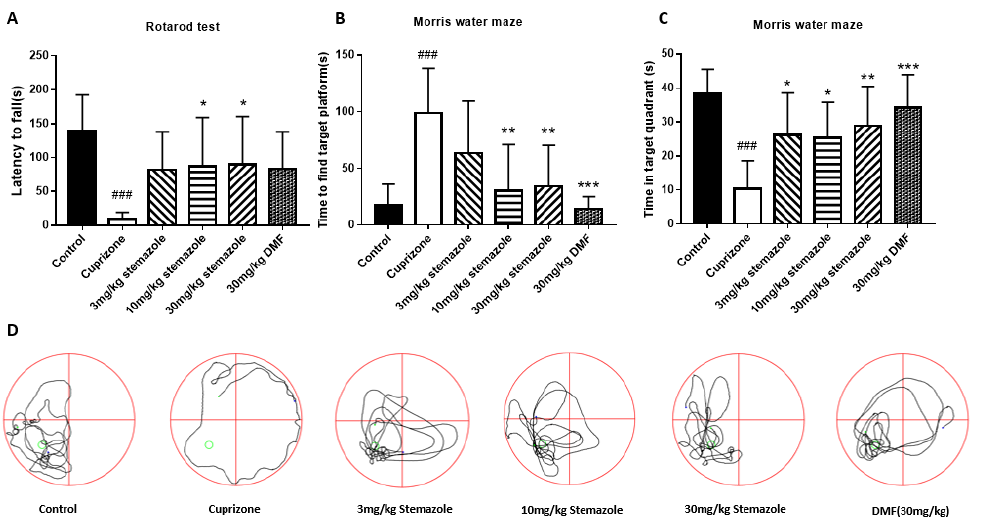
Figure 4. Function of stemazole on CPZ-induced spatial cognition and memory impairment by the Morris water maze task and rotarod test. Latency to fall ( A ), Time to find the target platform ( B ), Number of platform crossings ( C ), and Swimming tracks ( D ) were recorded via a video tracking camera system. Data represent the means ± SD (n = 10 duplicates). * p < 0.05, ** p < 0.01, *** p < 0.001 vs. the CPZ group. ### p < 0.001 vs. the control group.